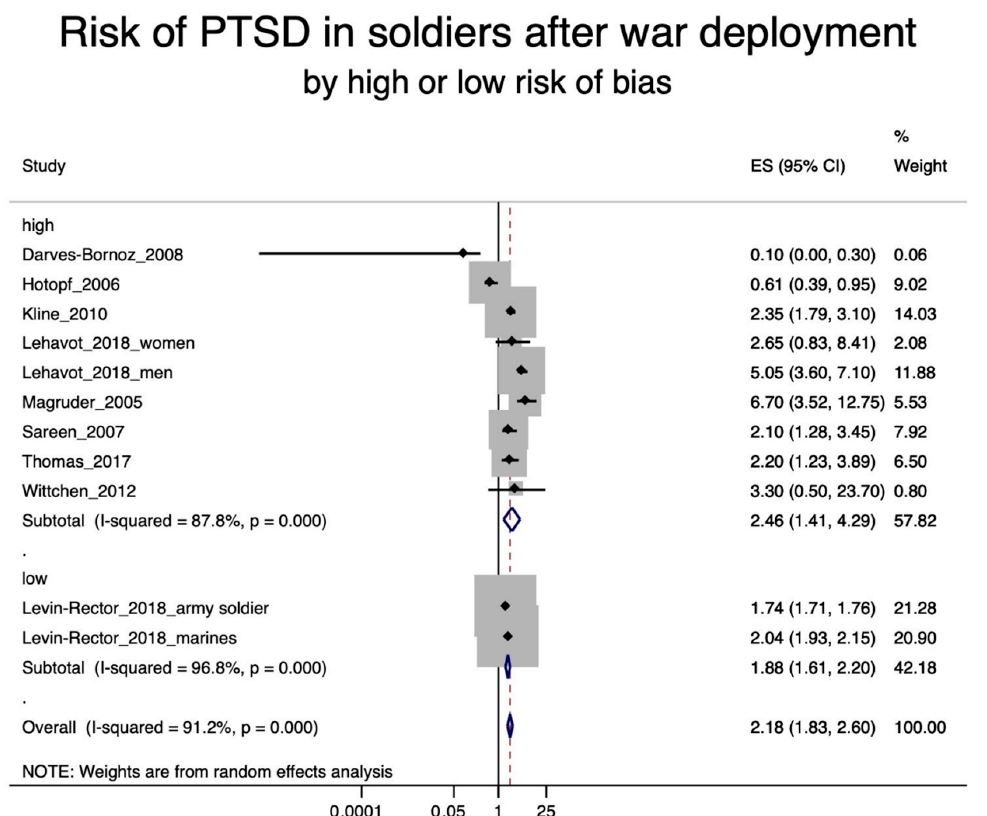
Figure 3. Forest plot of soldiers after war deployment and the estimates of e ff ect size (ES) for Figure 3 . Forest plot of soldiers after war deployment and the estimates of effect size (ES) for post-traumatic stress post-traumatic stress disorder (PTSD) by high or low risk of bias. disorder (PTSD) by high or low risk of bias.